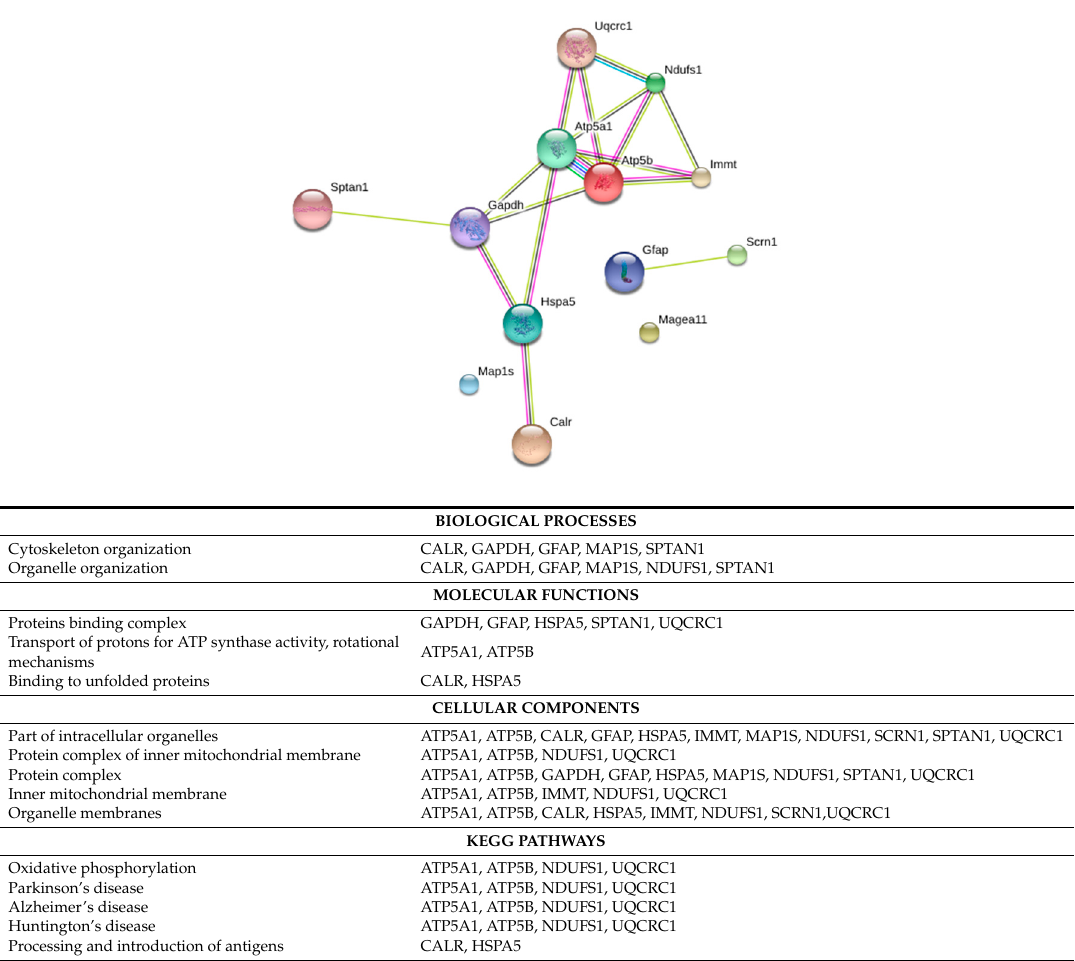
Figure 3. Rat-brain protein–protein interaction network differentially expressed after seven days of starvation. These data were obtained using STRING program, adjusting the classification to the first five